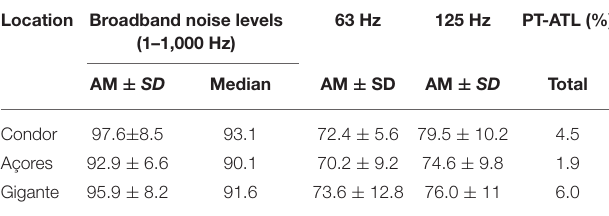
TABLE 3 | Arithmetic mean (AM) ( ± SD ) and median SPL at broadband levels (18–1,000 Hz) and one-third octave bands 63 and 125 Hz, and total PT-ATL for Condor, Açores and Gigante calculated over 9, 11, and 14 months, respectively. Location Broadband noise levels (1–1,000